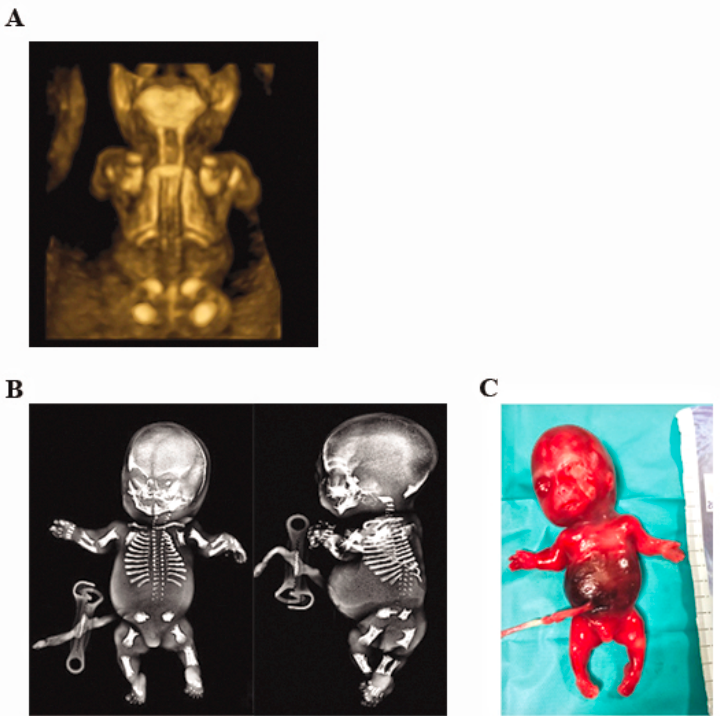
Figure 1. ( A ) Three-dimensional ultrasound image of the fetus showing reduced ossification of the sacrum, iliac spines, and arched femurs. ( B ) Radiograph of the fetus showing reduced ossification of the sacrum, iliac spines, and arched femurs. ( C ) Frontal view of the fetus postmortem.